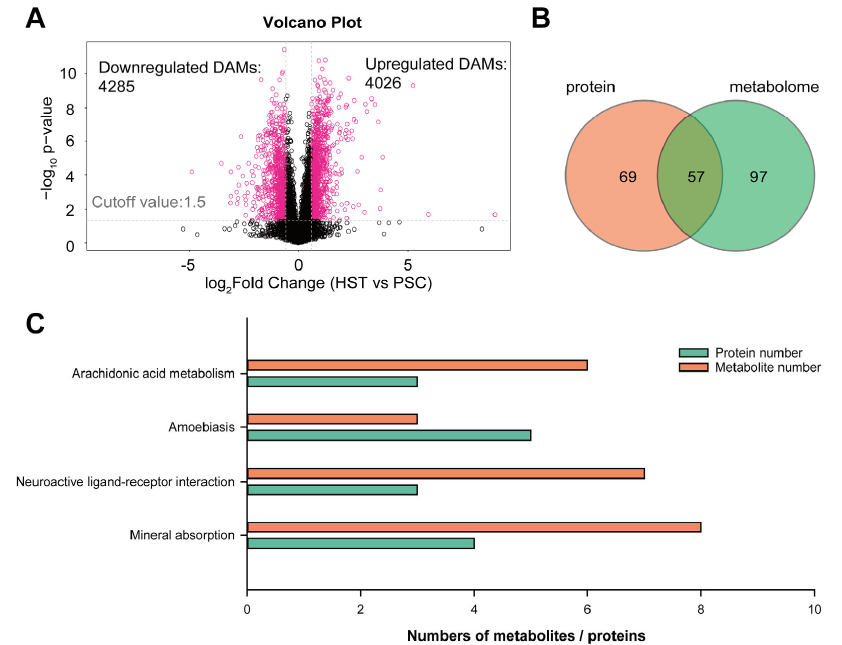
Figure 3. Integrative analysis on proteomics and metabolism using the spleen of mice subjected to either hypoxia and normaxia conditions. ( A ), Volcano plot representing the differentially abundant metabolites induced by hypoxia treatments. ( B ), Venn diagram representing the overlapped KEGG terms on DEPs and DAMs. ( C ), Overlapped top 4 KEGG terms on the list of DEPs and DAMs. DAMs, HST and PSC represent differentially abundant metabolites, hypoxia and normaxia, re ‐ spectively. In panel ( A ), significant DAMs were represented in pink color. Furthermore, we compared the expression levels of proteins and metabolites in ‐ volved in arachidonate acid metabolism, and found that arachidonate 15 ‐ lipoxygenase (Alox15), hematopoietic prostaglandin D synthase (Hpgds), prostaglandin G/H synthase (Ptgs2) and phospholipase D (Pld3) were significantly upregulated regarding their pro ‐ tein abundance from proteomics analysis (Figure 4A). Except for the arachidonic acid (peroxide free) (M303T39) and 1 ‐ stearoyl ‐ 2 ‐ oleoyl ‐ sn ‐ glycerol 3 ‐ phosphocholine (M855T142_1), 20 ‐ hydroxyarachidonic acid (M303T70), 15 ‐ deoxy ‐ delta ‐ 12,14 ‐ PGJ2 (M315T42), 8 ‐ iso ‐ prostaglandin A2 (M333T42) and prostaglandin D2 (M335T120) were all up ‐ regulated by hypoxia treatments ( p < 0.05) (Figure 4B). Then the qPCR experiments were conducted to determine the mRNA expression levels. Results show that the ex ‐ pression levels of Alox15 and Hpgds were upregulated by one and four times resulted by